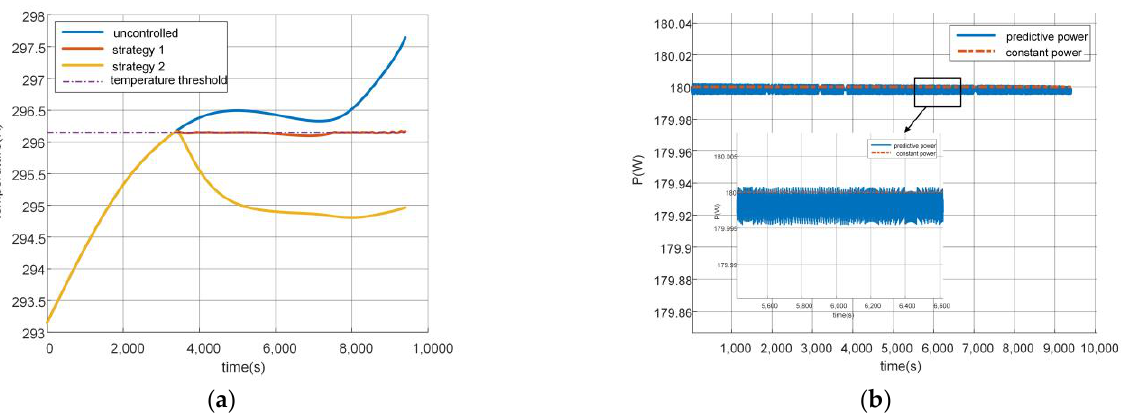
Figure 15. 180 W constant-power condition. ( a ) Temperature contrast. ( b ) Power comparison.